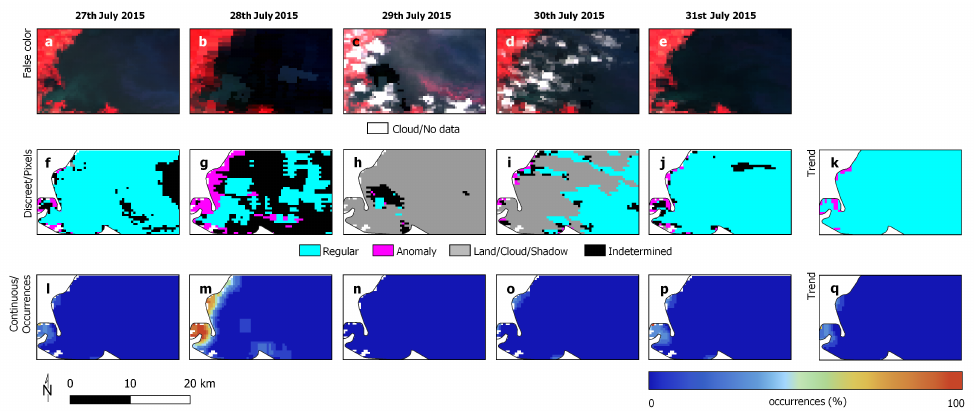
Figure 7. Images ( a – e ) in false-color composition (NIR, red and green bands) for the Lake Erie study area from 27–31 July 2015. Regular, anomaly, land/cloud/shadow and undetermined samples ( f – j ) are identified by cyan, magenta, gray and black polygons, respectively; ( l – p ) show the local anomaly concentration at each instant; ( k , q ) represent the discrete and local anomaly concentration references for the whole forecasting